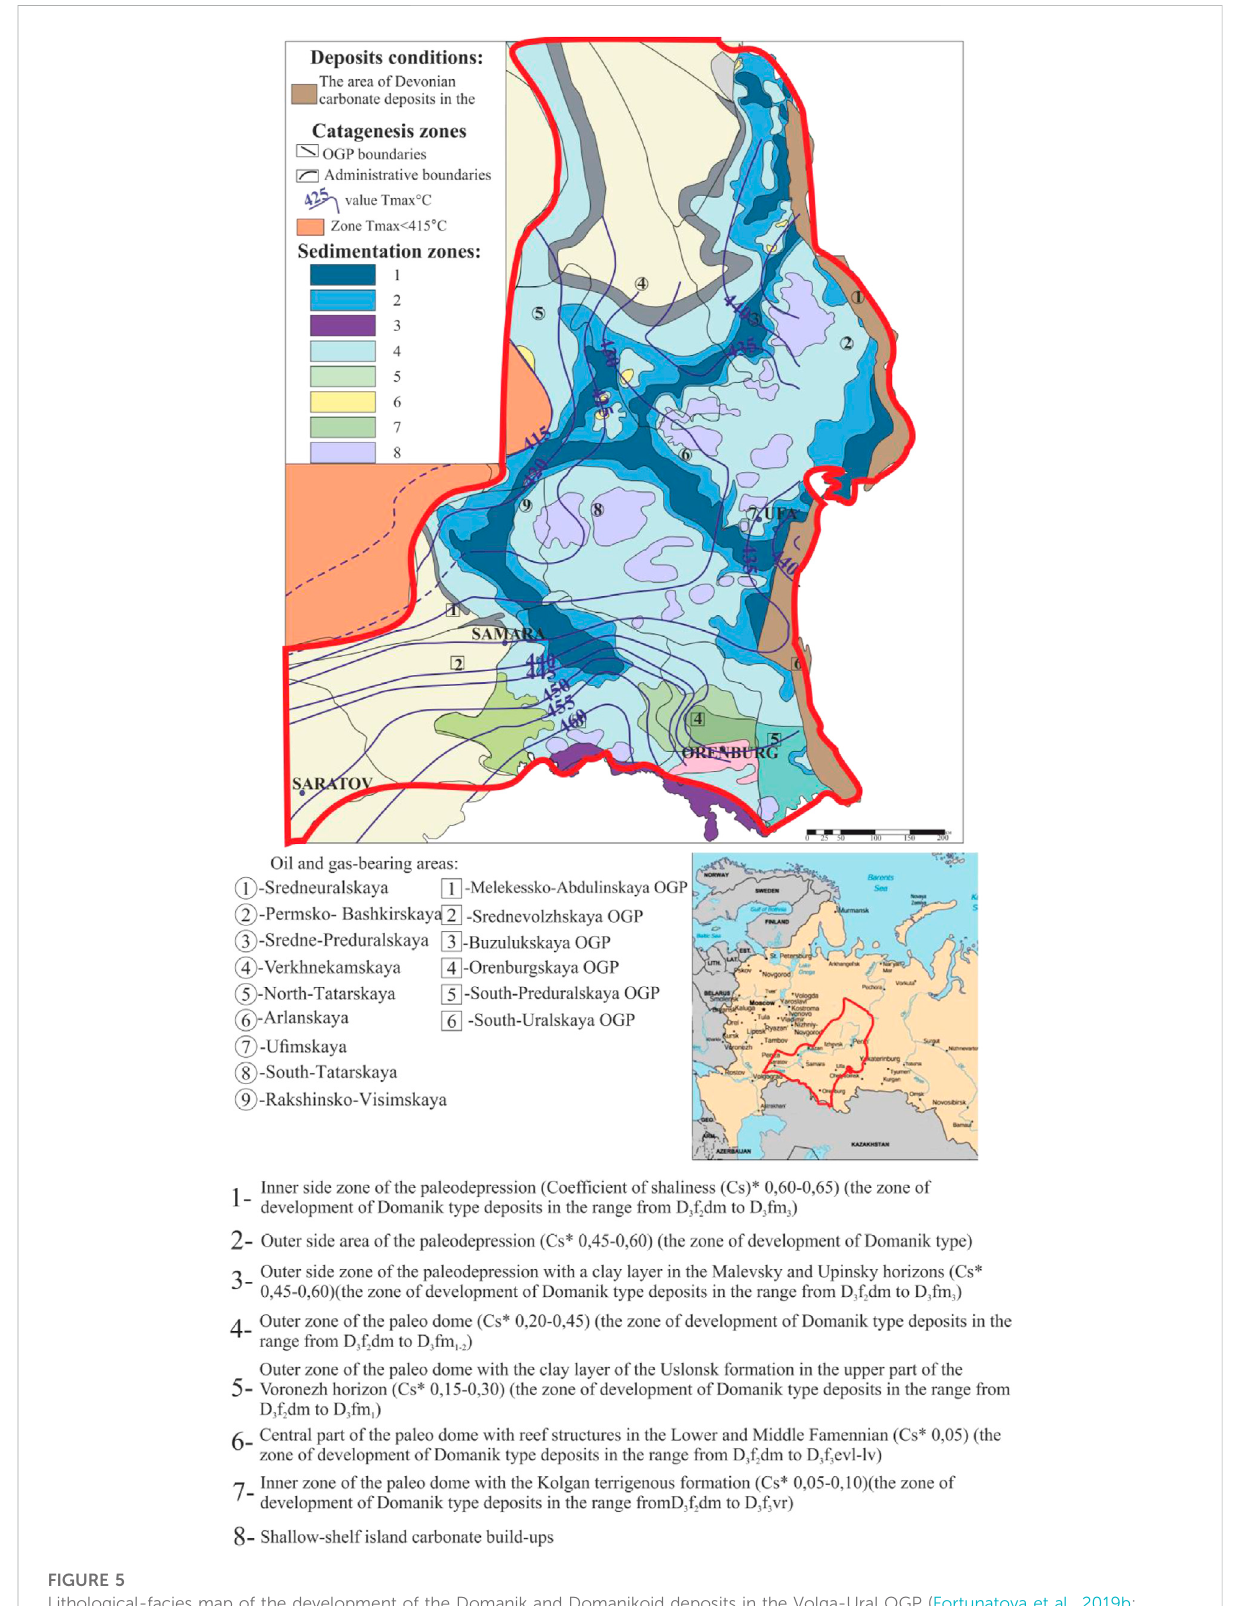
FIGURE 5 Lithological-facies map of the development of the Domanik and Domanikoid deposits in the Volga-Ural OGP (Fortunatova et al., 2019b; Varlamov et al., 2020).